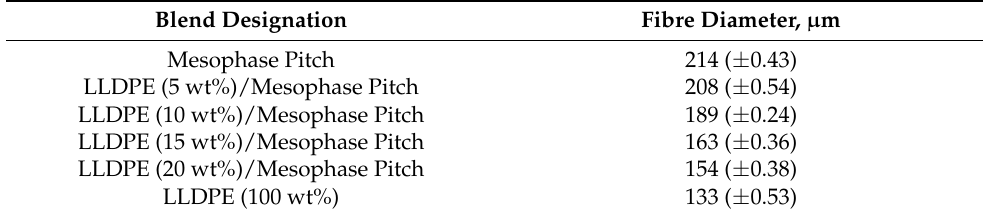
Figure 3. Optical microscope image of fibres with different LLDPE content. ( a ) Mesophase pitch, ( b ) 5 wt% LLDPE/mesophase pitch ( c ) 10 wt% LLDPE/mesophase pitch, ( d ) 15 wt% LLDPE/mesophase pitch, ( e ) 20 wt% LLDPE/mesophase pitch and ( f ) LLDPE. Table 2. Blends in terms of wt% mesophase pitch and LLDPE fibres